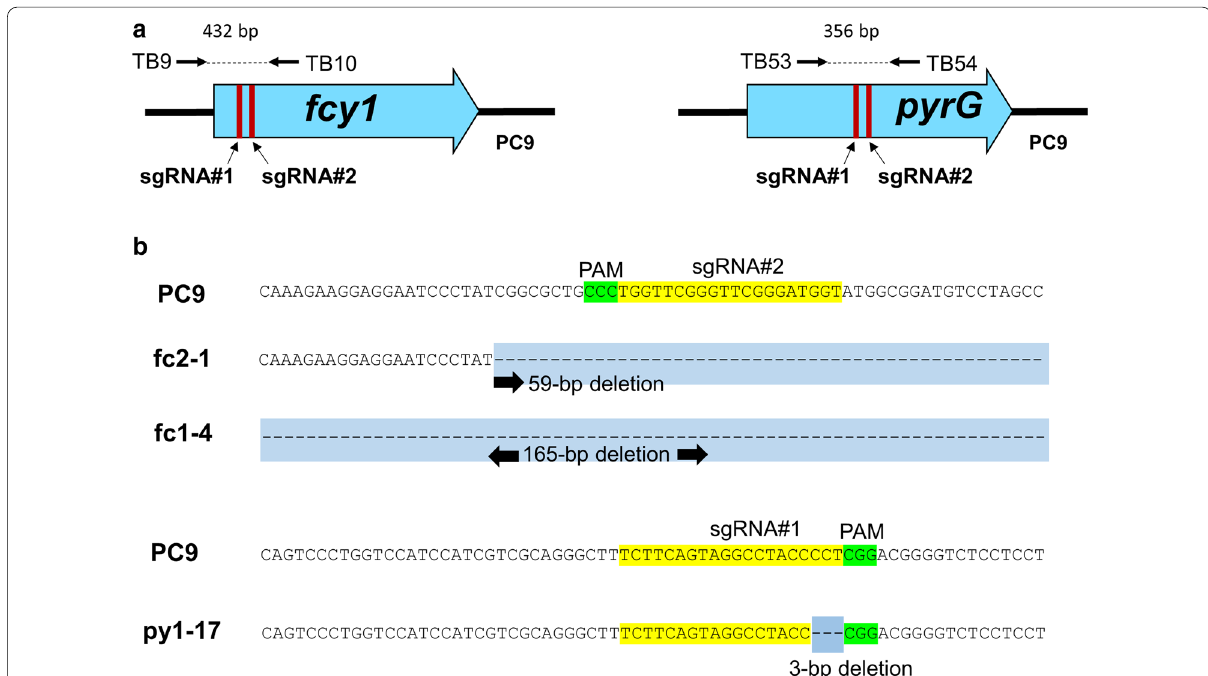
Fig. 2 Identification of fcy1 and pyrG mutations in some strains. a A schematic diagram of the fcy1 and pyrG loci in the PC9 host strain with sgRNA recognition sites. The dash lines indicate the region amplified by genomic PCR. Black arrows display the primer pairs used for the PCR experiments in Additional file 1: Fig. S2A and B. b DNA sequencing to identify small indel mutations in fcy1 or pyrG mutants. For highlights in the nucleotide sequence: yellow shades indicate sgRNA, green shades indicate a protospacer adjacent motif (PAM) sequence, and dash lines indicate